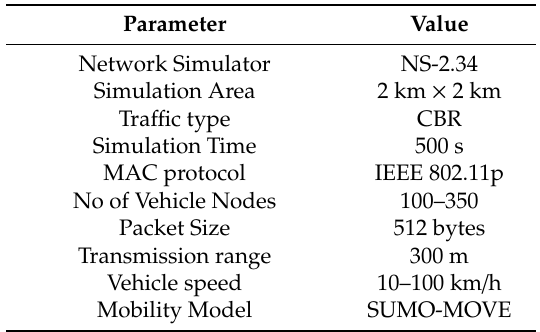
Figure 4. Fragmented city map of Chicago city. Table 3. Major simulation setup parameters. CBR: constant bit rate; SUMO-MOVE: simulation for urban mobility-mobility model generator for VANETs.